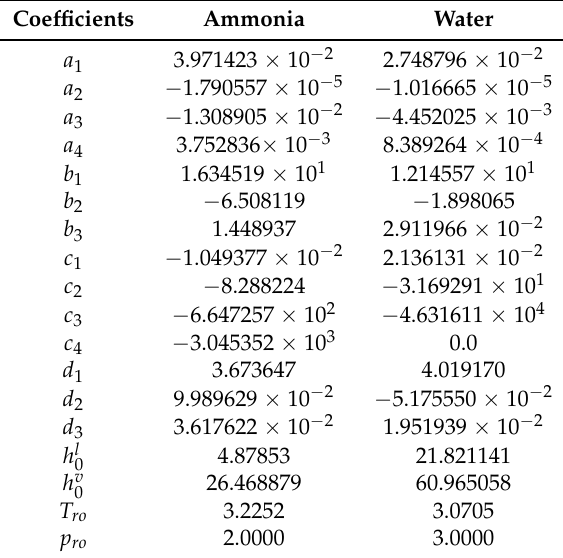
Table 3. Coefficients for Equations (27) and (28).